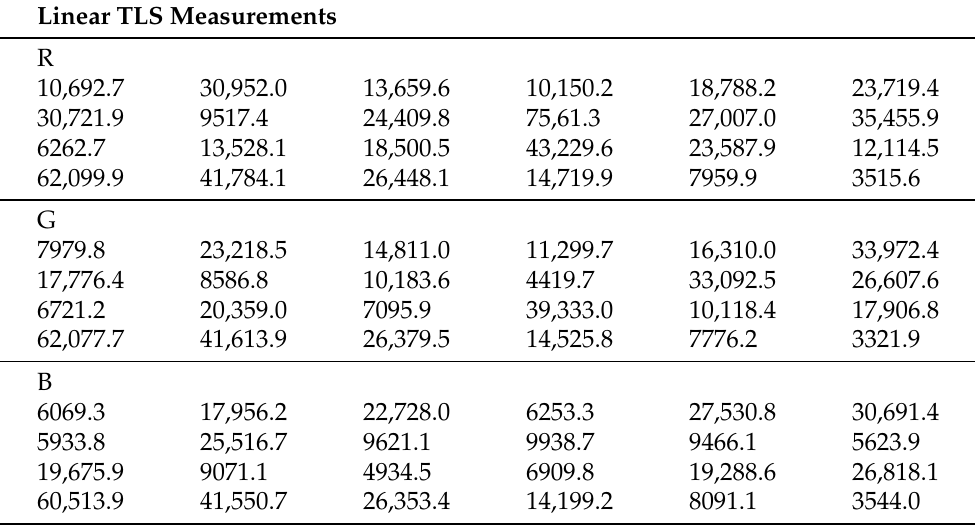
Table A1. Linear TLS measurement scaled to be comparable with the X-Rite color target values for each channel R, G, and